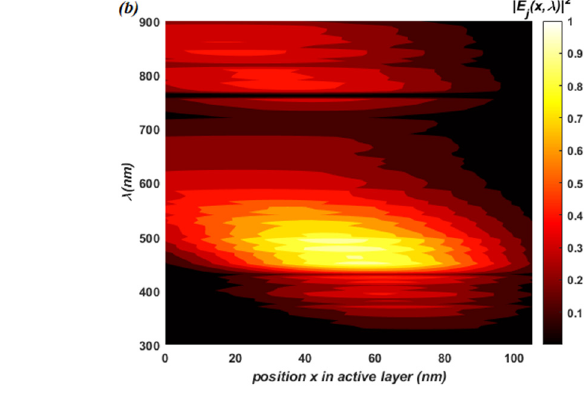
Figure 7. Contour plots of the electric field distribution (cid:3627)𝐸 (cid:3037) (𝑥)(cid:3627) verted and ( b ) in conventional OSCs.